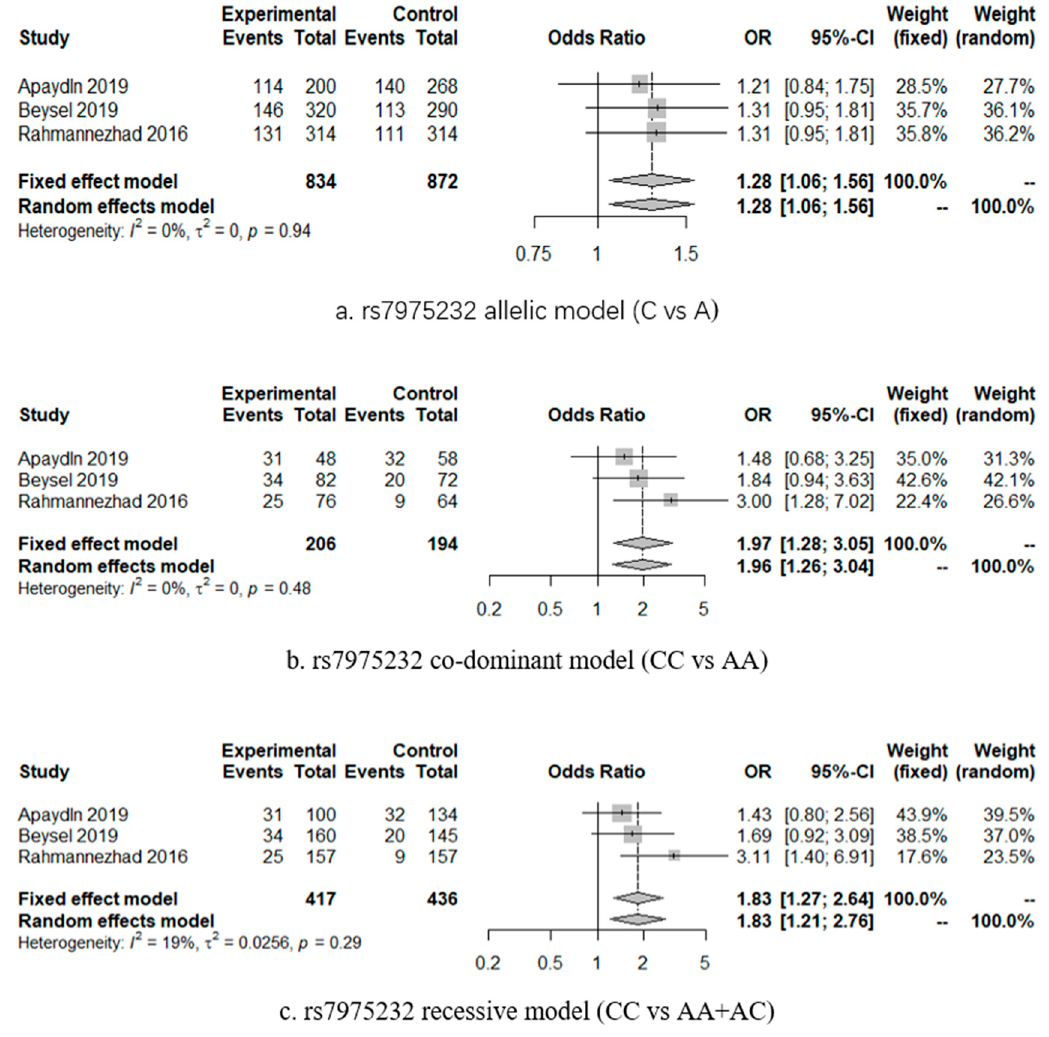
Figure 2. Forest plots of the significant results. ( a ) rs7975232 allelic model (C vs. A); ( b ) rs7975232 co-dominant model (CC vs. AA); ( c ) rs7975232 recessive model (CC vs. AA + AC).